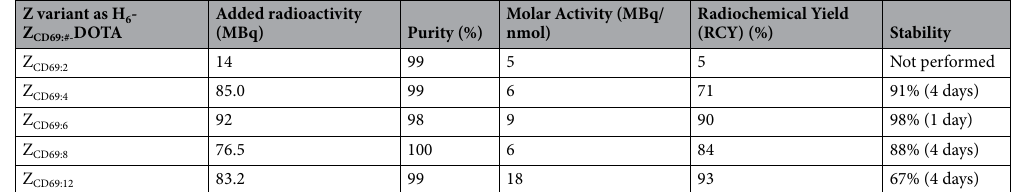
Z variant as H 6 - Z CD69:#- DOTA